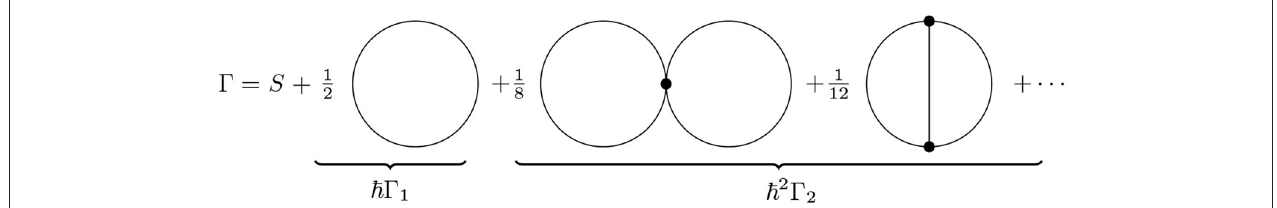
FIGURE 1 | The diagrammatic expansion of the quantum effective action in powers of